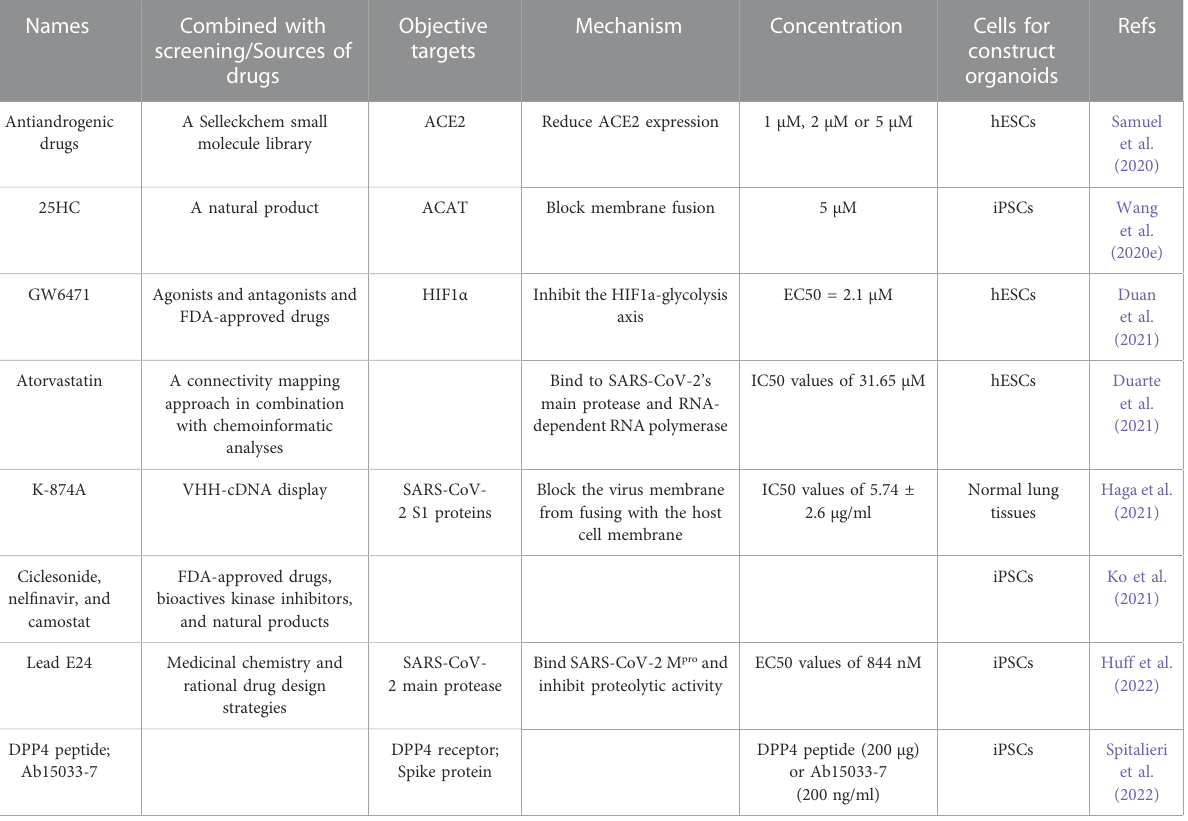
TABLE 5 Drugs against SARS-CoV-2 discovered/tested by human lung